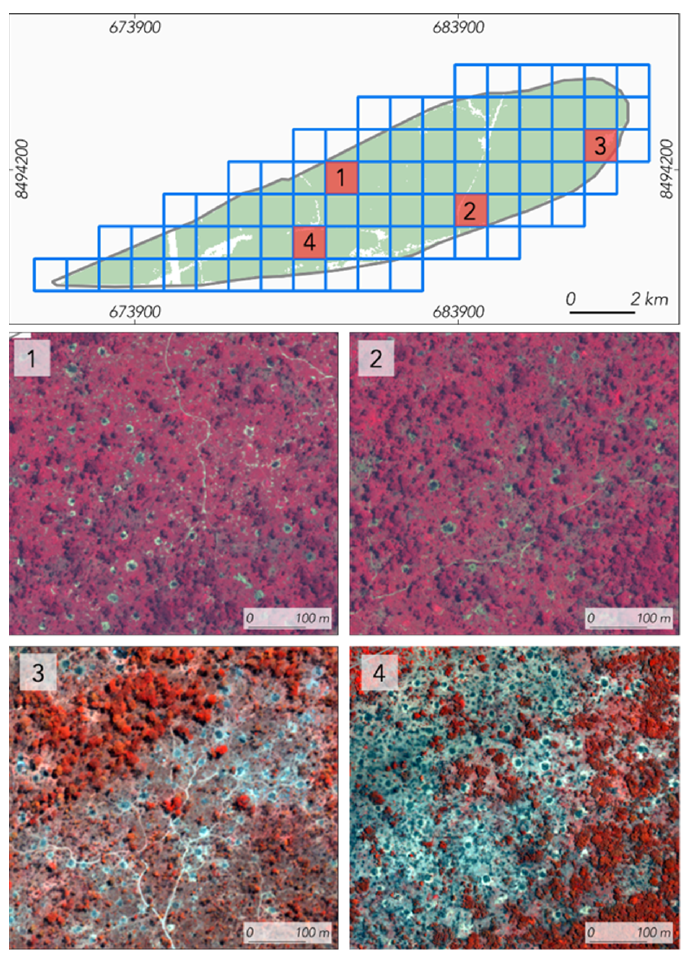
Figure 7. Forest degradation process in four randomly selected grid cells (1 × 1 km) in the Katarino forest reserve. Evidence of kiln scars in grid cells serves to attribute forest degradation to charcoal production. False-color composition (1,2,4).